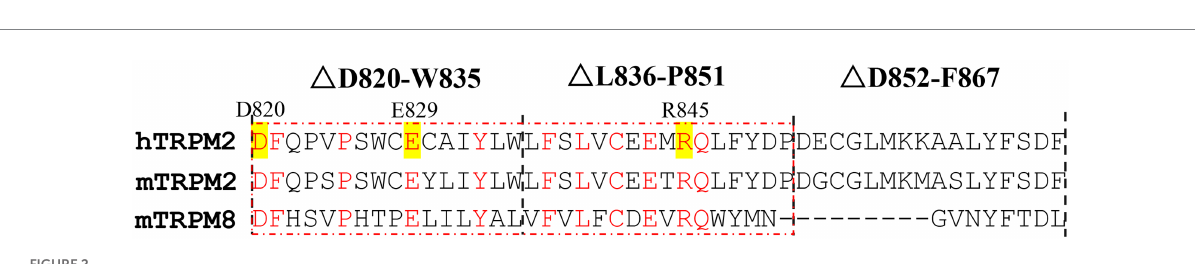
FIGURE 2 Sequence alignments between hTRPM2, mTRPM2, and mTRPM8. The sequence alignments were done for the residues in the red dashed box. Apart from the residues constitute the Ca 2+ binding site (E843 and Q846), residues with high conservation were marked in red, and the polar and charged ones among them were highlighted in yellow (D820, E829, and R845).